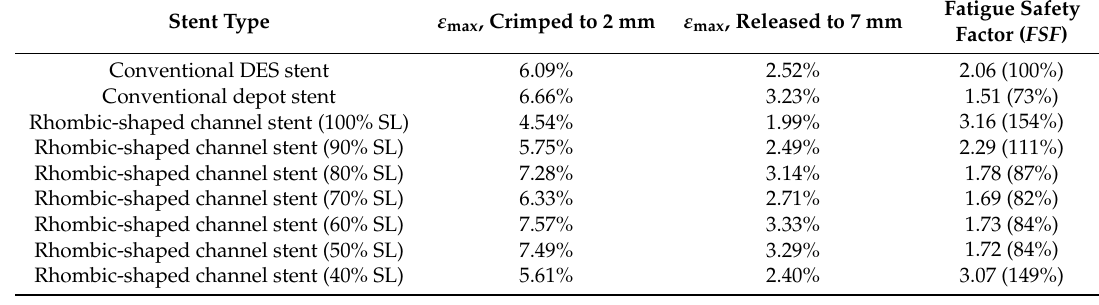
Table 2. Maximum strain and fatigue safety factor as a function of narrowed strut width.